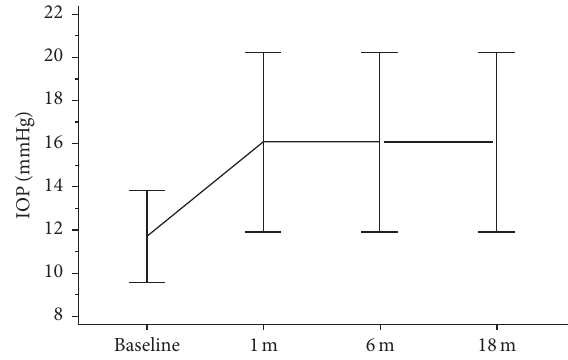
Figure 1: Mean IOP (in mmHg) at baseline, 1 month, 6 months, and 18 months